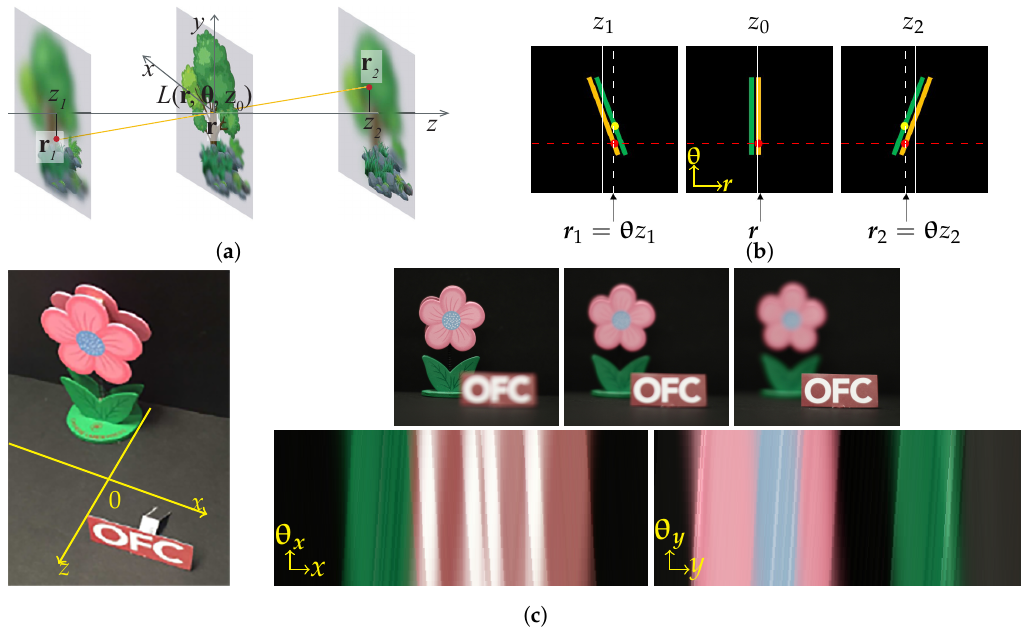
Figure 8. Principle of light field reconstruction with back projection (LFBP) represented in the spatial domain ( a ) and by Wigner distribution function (WDF) ( b ), and an example of the reconstructed epipolar plane images (EPIs) of a real 3D scene ( c ), adapted with permission from [66], Optical Society of